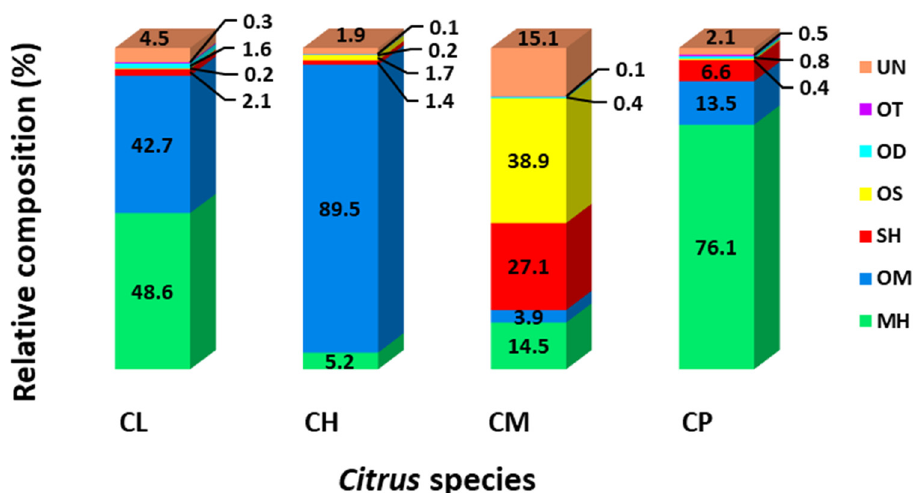
Figure 2. Relative phytochemical compositions (%) of the analyzed Citrus spp. leaf essential oils: C. limon (CL), C. hystrix (CH) , C. microcarpa (CM), and C. pyriformis (CP). The constituents included monoterpenic hydrocarbon (MH), oxygenated monoterpenes (OM), sesquiterpenic hydrocarbon (SH), oxygenated sesquiterpene (OS), oxygenated diterpenes (OD), other subgroups of metabolites (OT), and unidentified compounds (UN).